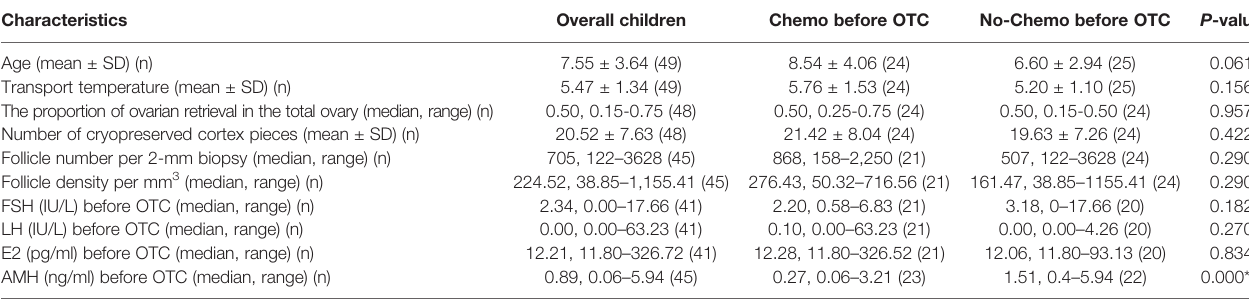
TABLE 1 | Patient characteristics and comparison with chemotherapy and without chemotherapy before OTC.